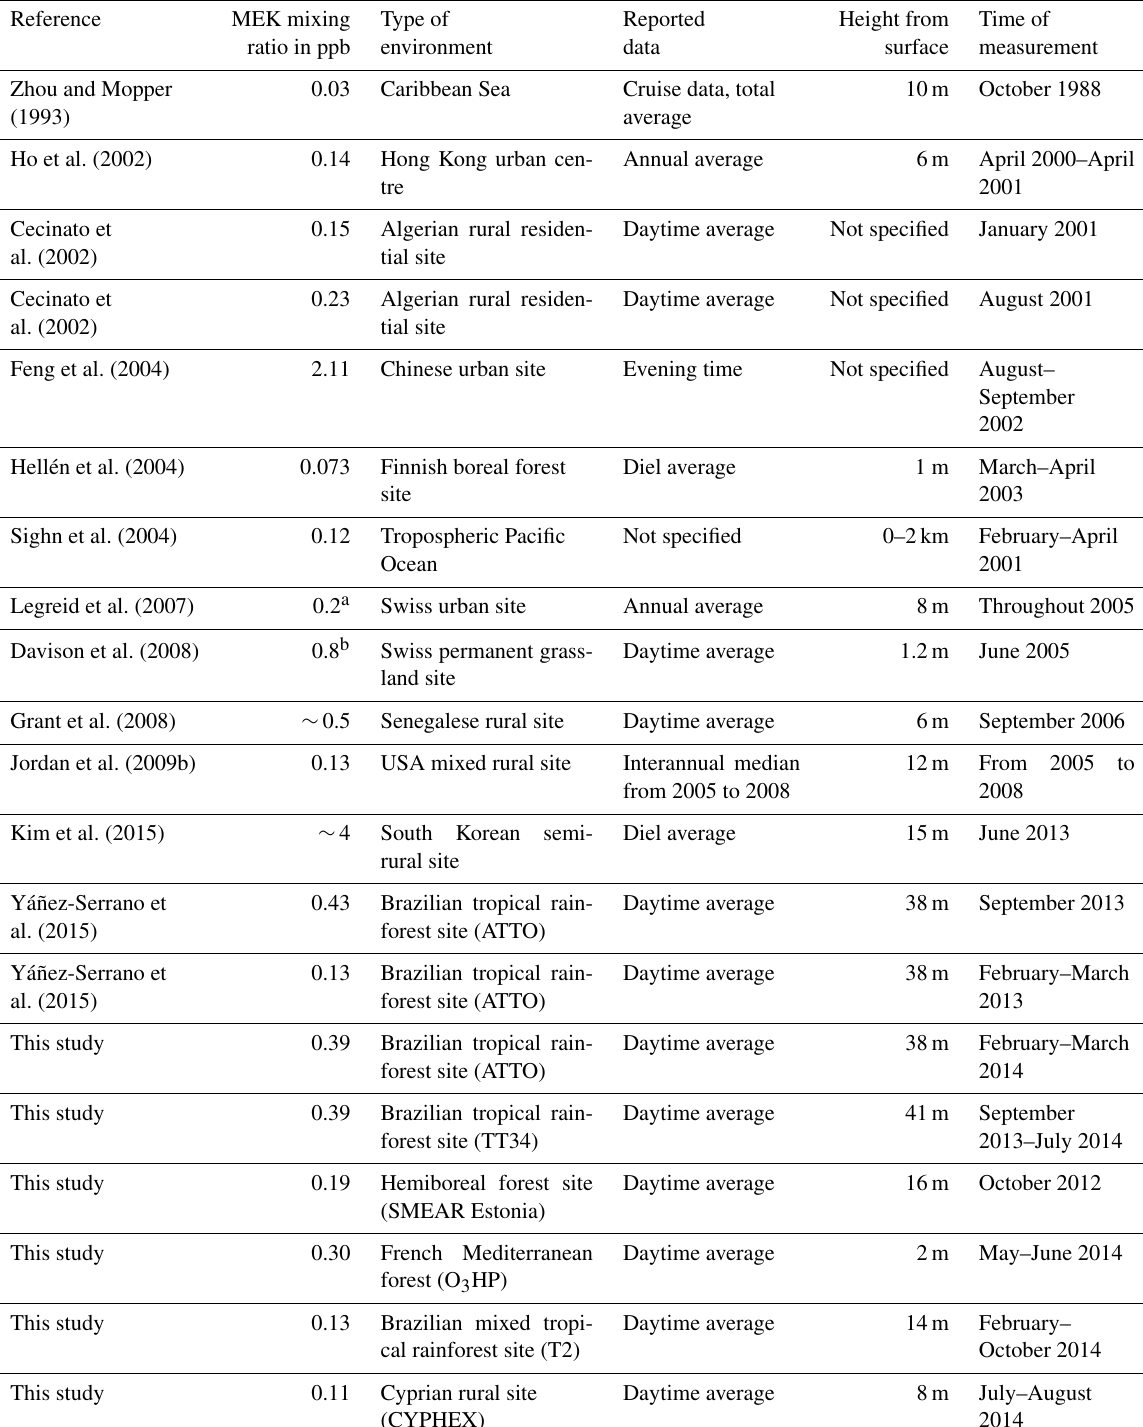
Table 4. Literature compilation of MEK mixing ratios measurements in different ecosystems around the globe from a wide range of atmo- spheric